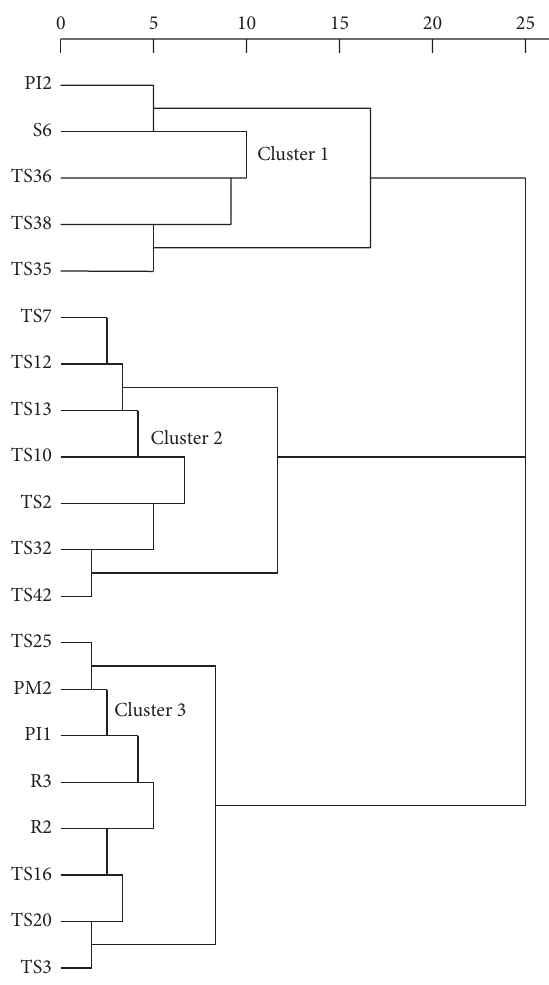
Figure 4: Classification of studied sites.